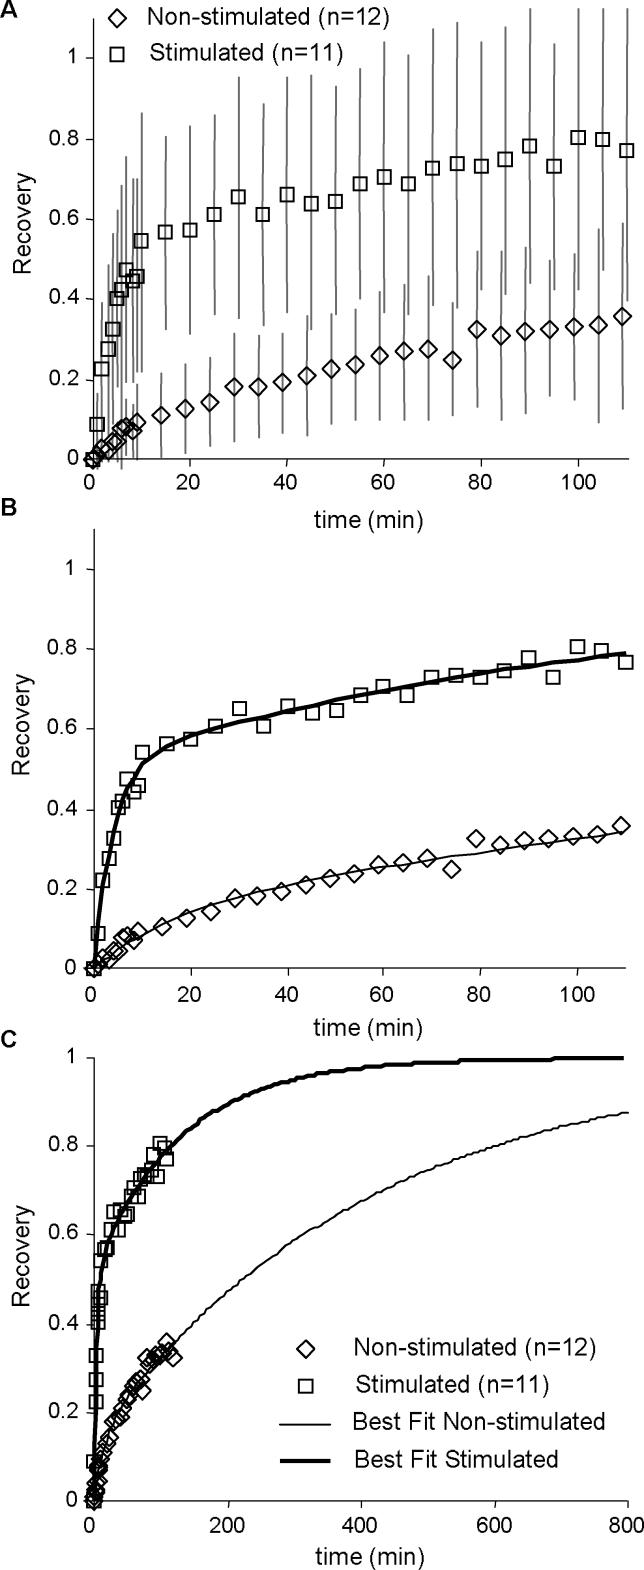
Synaptic Activity Accelerates GFP:ProSAP2 Loss and Reincorporation Rates(A) Mean recovery time course for all photobleached puncta in three separate experiments identical to that shown in Figure 4. Data shown are mean ± standard deviation for all photobleached puncta.(B) The data were fit according to a model that assumed two GFP:ProSAP2 pools with different recovery kinetics as described in the text.(C) Extrapolation of recovery time courses using the recovery rates and relative pool sizes that provided the best fit to the data.